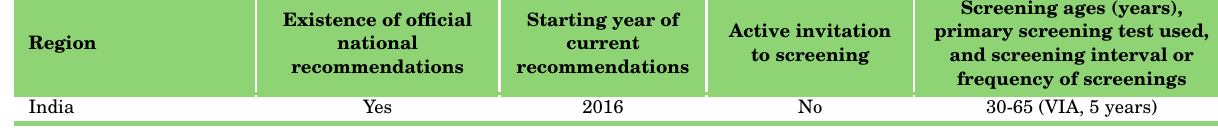
Table 45: Main characteristics of cervical cancer screening in